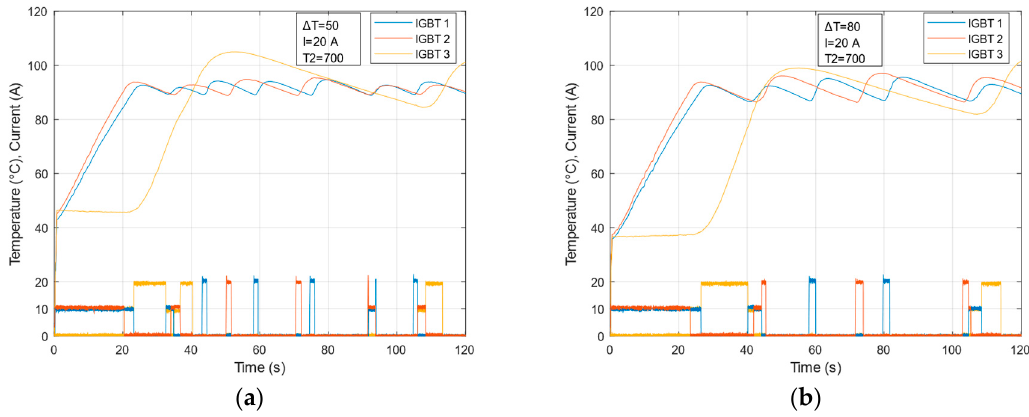
Figure 14. Hysteresis Δ T influence for two main and one redundant IGBTs for ( a ) Δ T = 50; ( b ) Δ T = 80. Table 6. Measurement results of NNr algorithm for two main and one redundant IGBTs.